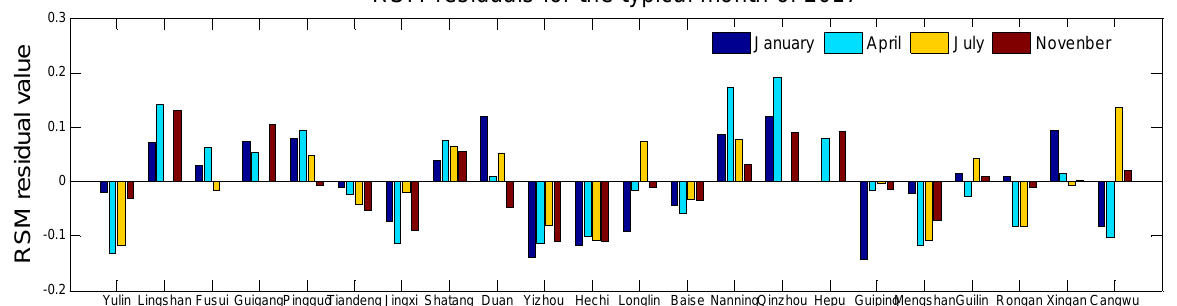
Figure 4. Relative soil moisture residuals for the typical month of 2017